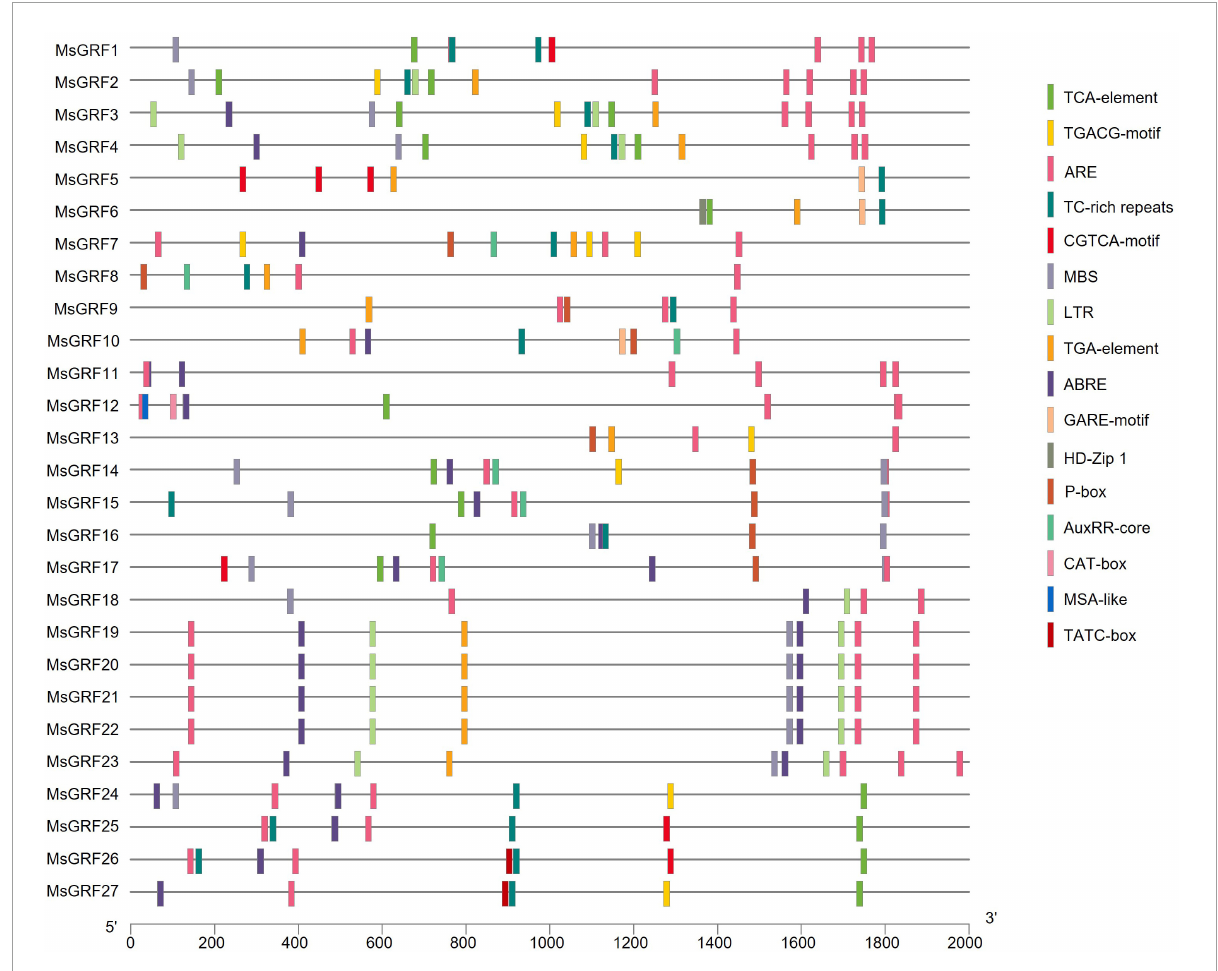
FIGURE5 The cis -acting element contained in the 2 kb promoter sequence of the MsGRF gene. Different cis -elements are indicated by different colored rectangles and placed in the matching position on the